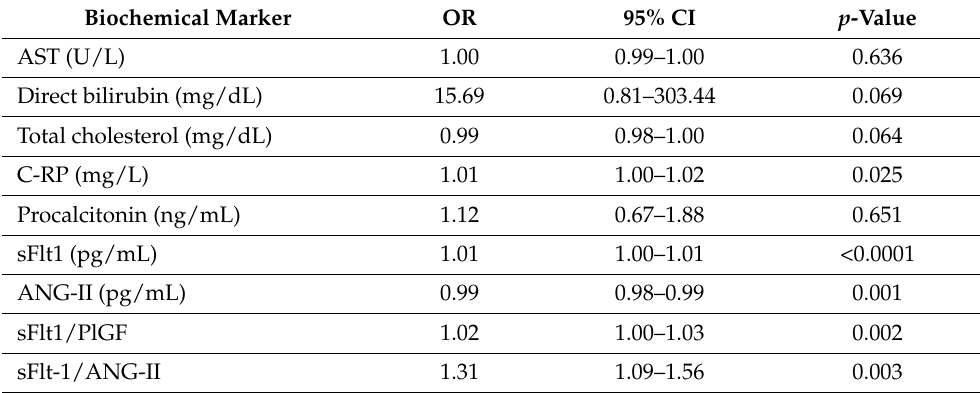
Table 3. Association between biochemical markers and severe